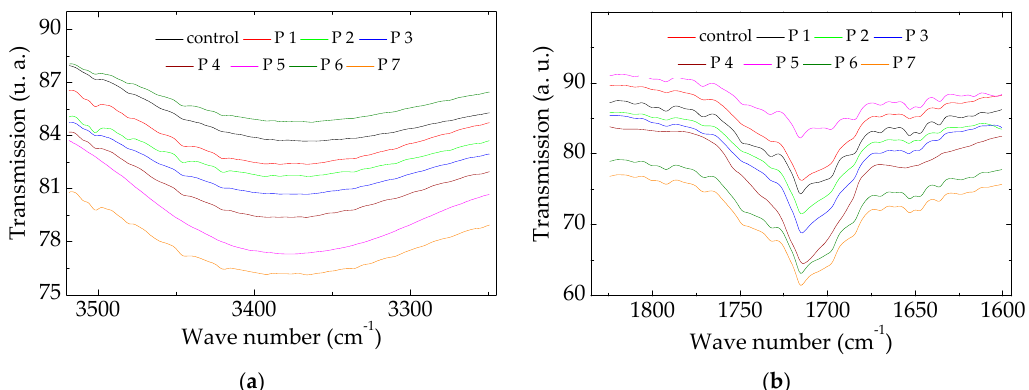
Figure 10. The distribution of FTIR spectra of PP hybrid modified with the same filler in irradiated at 100 kGy. ( a ) hydroxyl band; ( b ) carbonyl band.